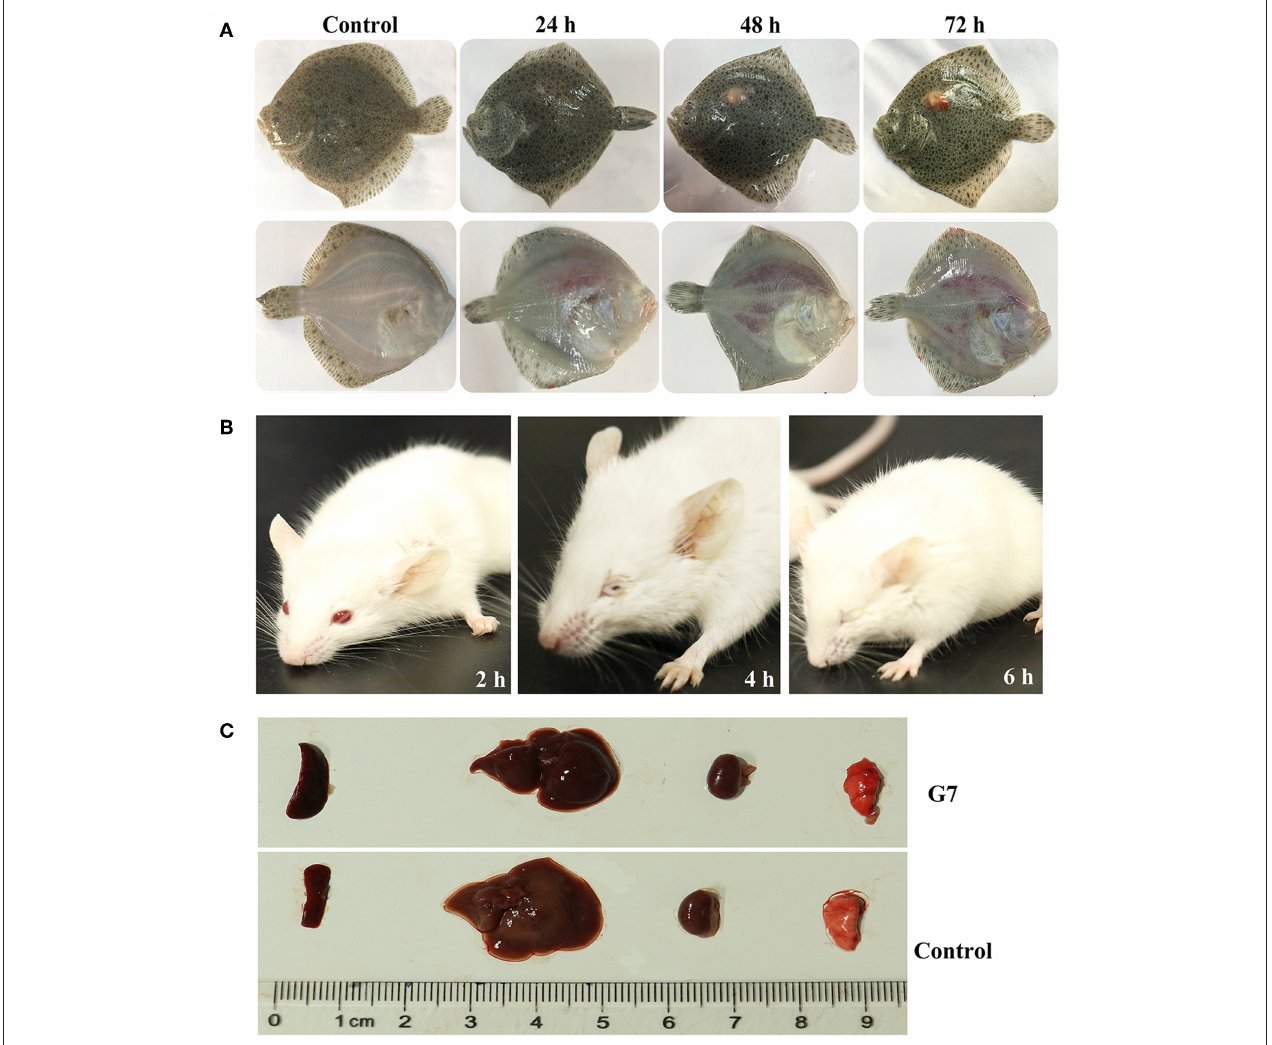
FIGURE 5 | Symptoms of G7-infected animals. (A) Turbot were infected with or without (control) G7 and observed at different hours after infection. (B) G7-infected and uninfected (control) mice were observed at different hours post infection. (C) Organs of G7-infected and uninfected (control) mice were compared. The result is one representative of three